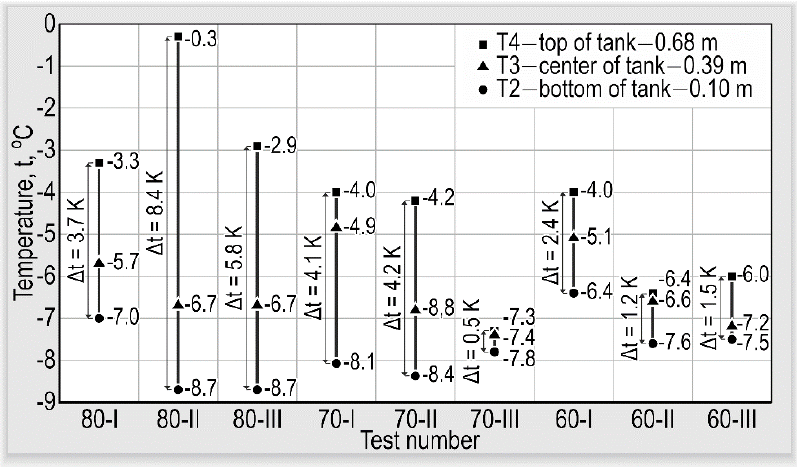
Figure 7. The final value of temperature in capsules for measurement points T2, T3, and T4. As can be seen in Figure 7, lower temperature gradients occurred for tests with 60- and 70-mm-diameter capsules. In the majority of the tests, the degree of overcooling